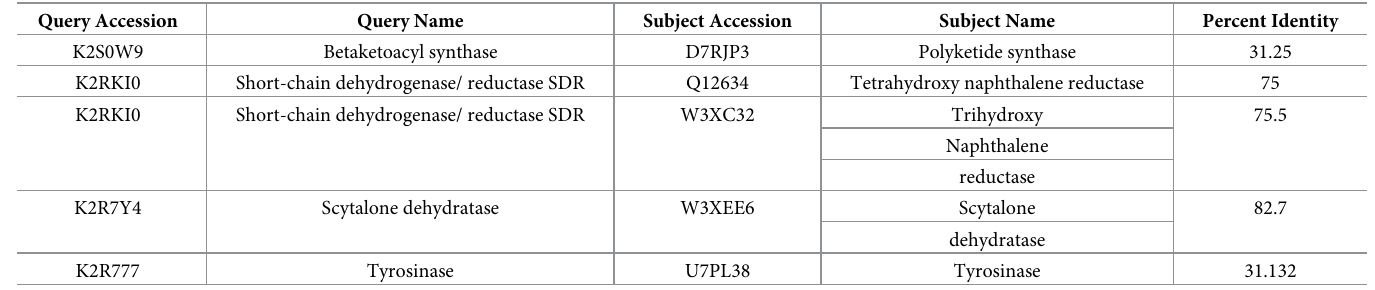
Table 5. Homologous proteins of melanin pathways found in M . phaseolina